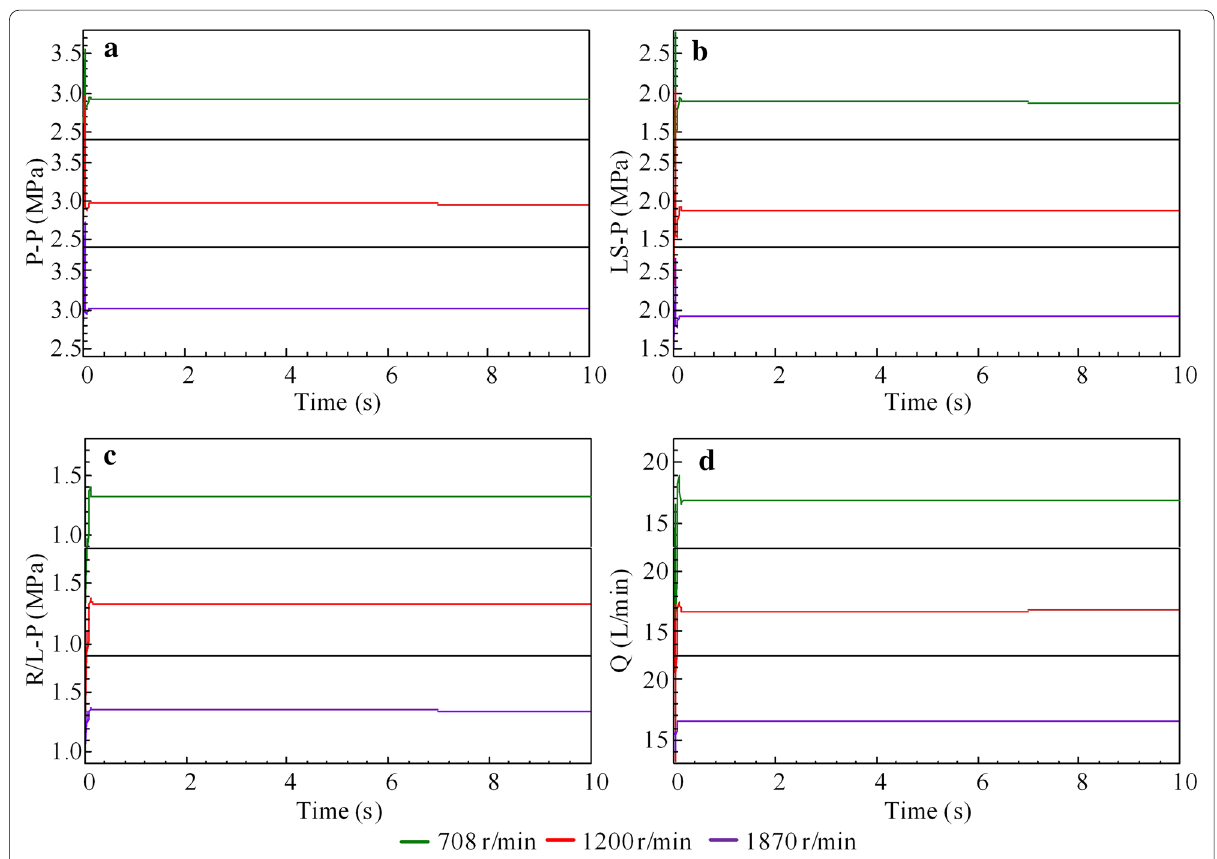
Figure 9 Simulation results under no load condition and steering wheel speed of 20 r/min: a P , b P LS , c P R / L , and d